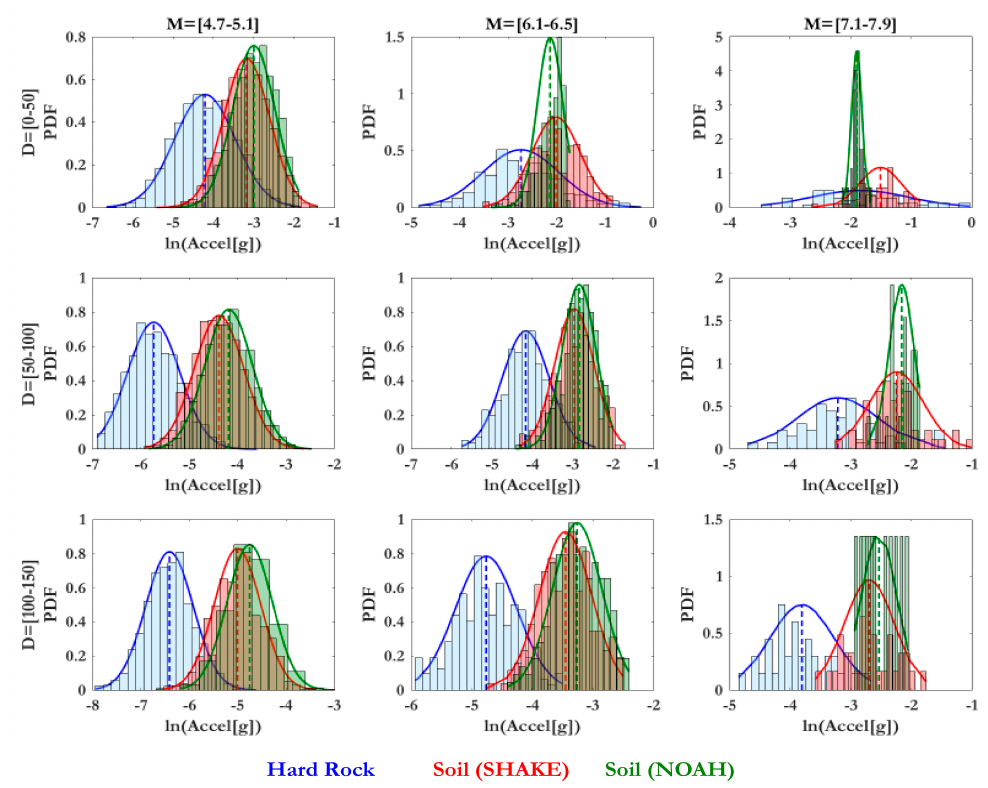
Figure 13. Probability density function (PDF) of the ground motion acceleration (PGA) on hard rock (blue) and on soil after performing 1D site response analysis using SHAKE91 (red) and NOAH (green) for different ranges of magnitudes (columns) and distances (rows).